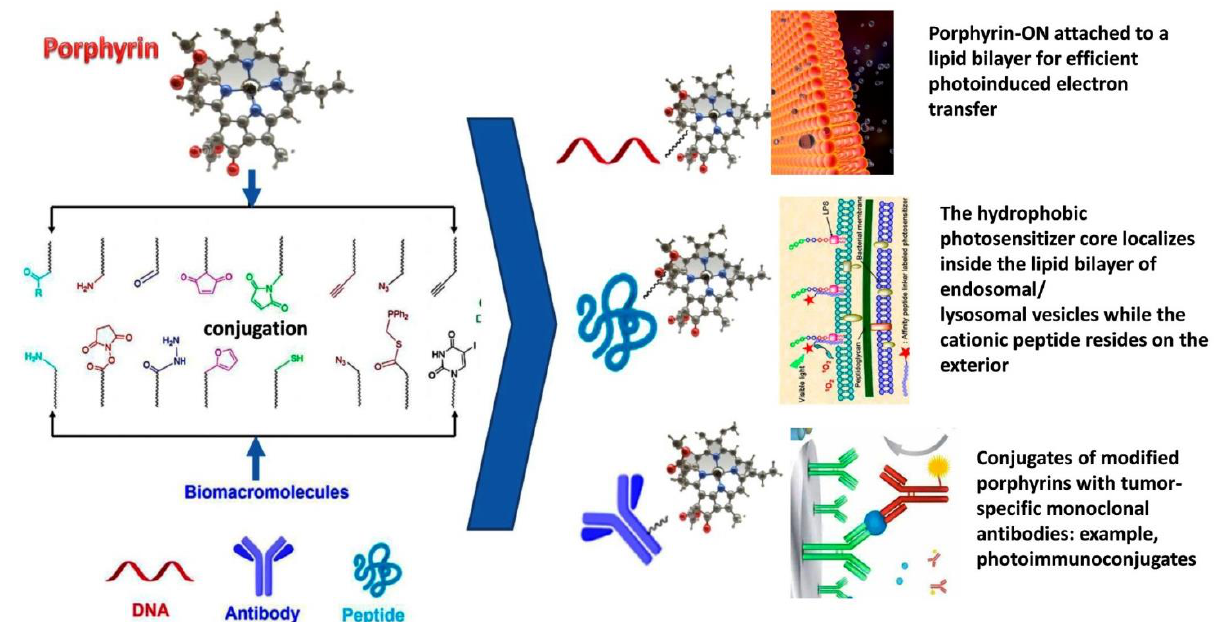
Figure 2. Schematic of the attachment of porphyrins to biomacromolecules using functional groups or bio-orthogonal pairs and some applications of the conjugates.